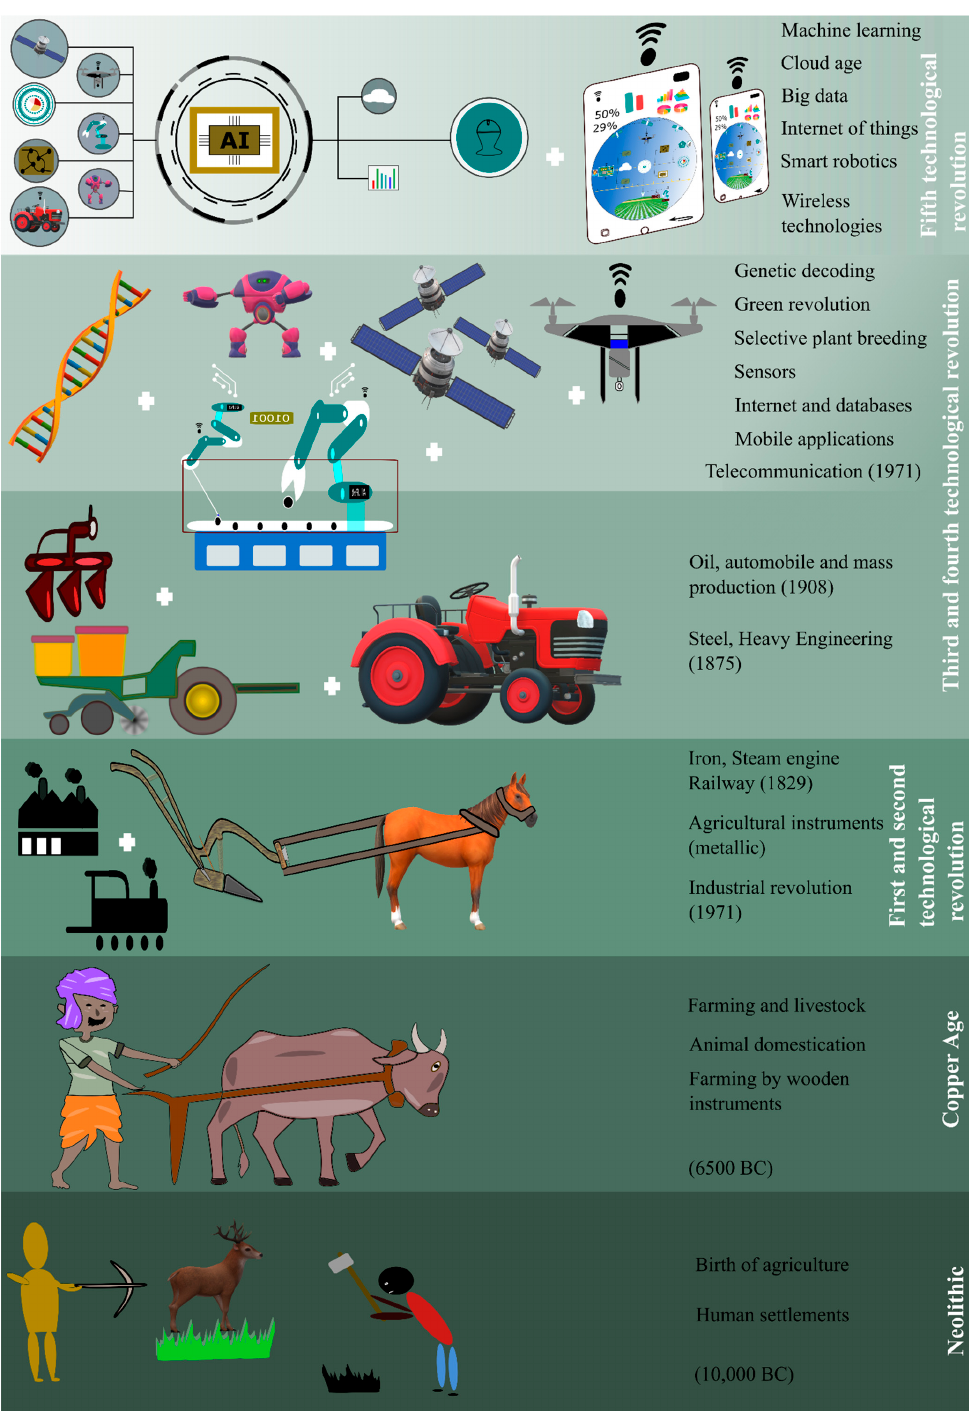
Figure 1. An illustration of industrial revolutions, with respect to agriculture, over time. Representative events/technologies are mentioned in each respective technological era, although they are not limited to only